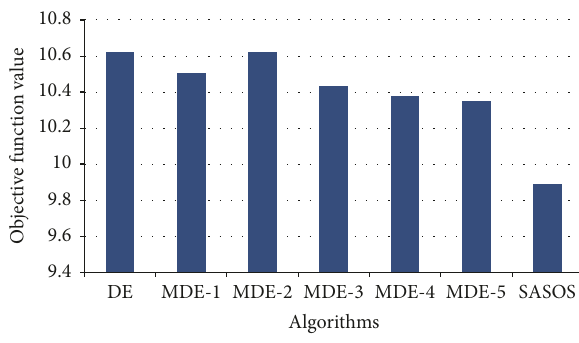
Figure 8: Comparison of number of function evaluations done, for obtaining the best results, by SASOS algorithm with DE and its modified versions for 6-bus model.